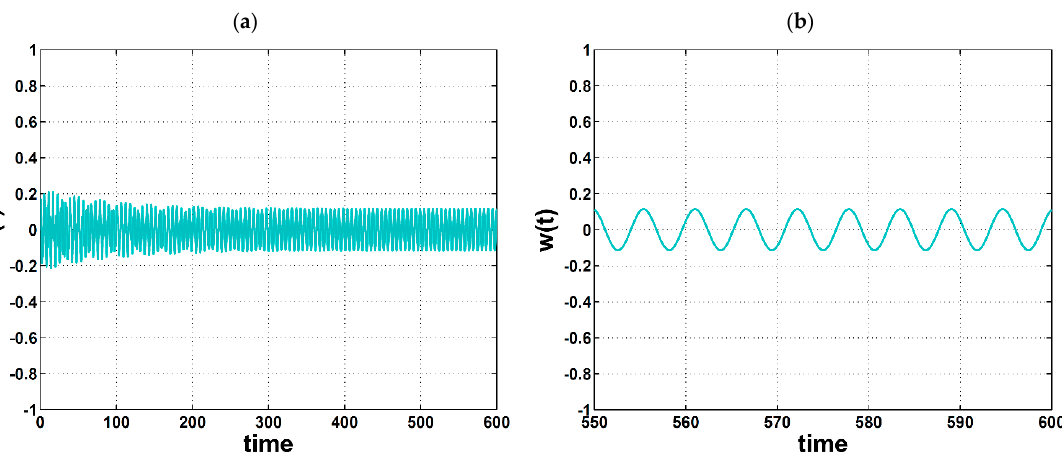
Figure 13. The time history of the car pre-control ( (cid:1863) (cid:3043) = (cid:1863) (cid:3049) = 0 ) at (cid:2033) = 1.12 , (cid:1863) = 7 , (cid:2010) = 0.8 , and (cid:2014) = 0.02 : ( a ) total trace for 600 s and ( b ) last 50 s of the total trace.